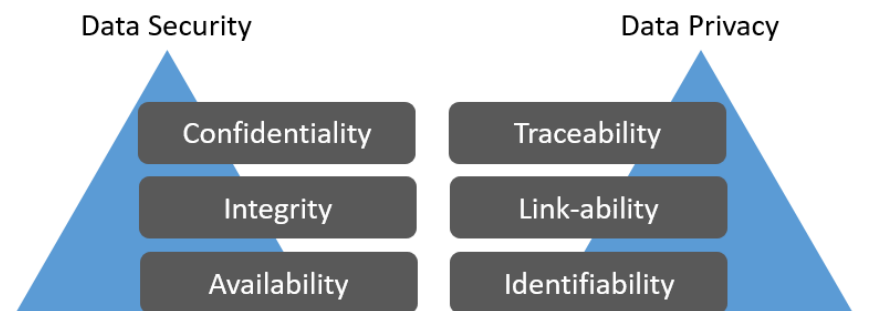
Figure 1. Privacy vs. Security.